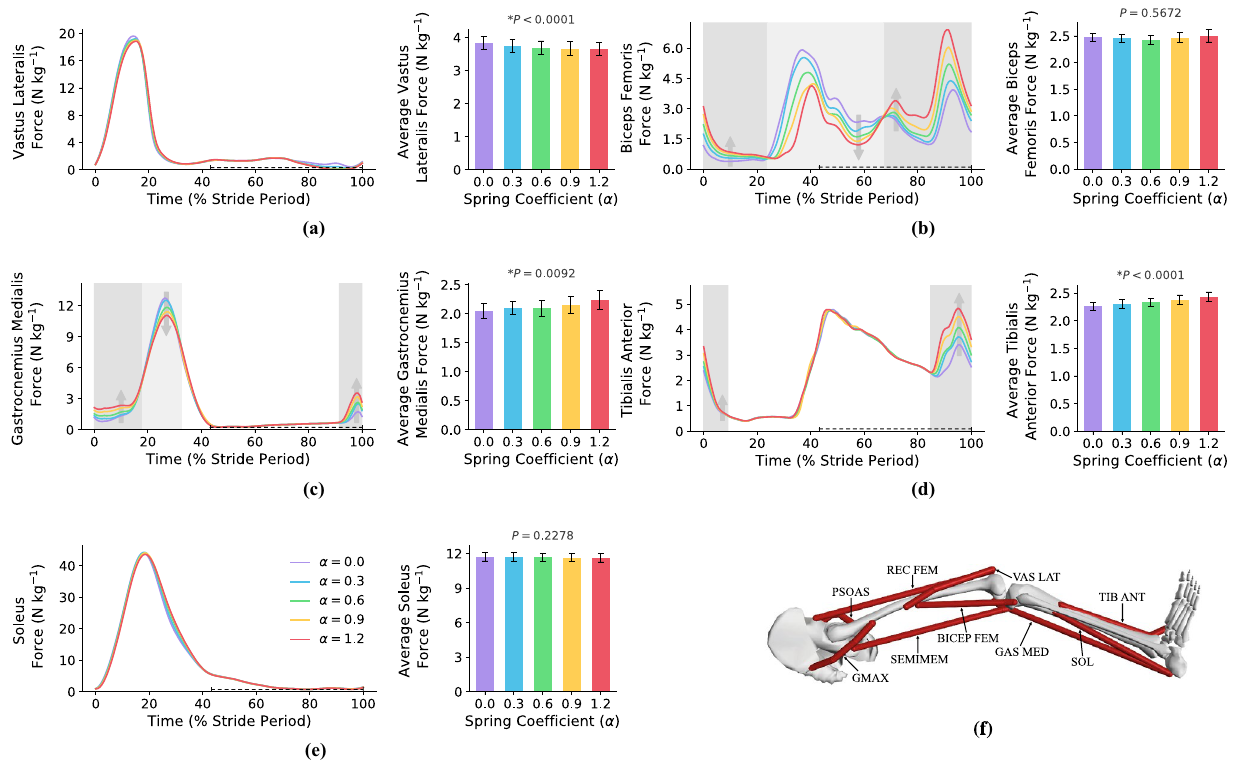
Figure 5. Other muscles’ forces . ( a – e ) Sub-figures show the effects of exoskeleton augmentation on the main muscles’ forces and their average over the whole stride except for the main hip muscles. The start of the gait cycle is at the heel-strike instant of the right leg, and all of the figures are for the right leg. The swing phase is shown with a dashed line over the horizontal axes. The background color code for all of the sub-figures is: white means no special effect, light gray means muscle force reduction, and dark gray means muscle force increment. As can be seen, the force of Soleus and Vastus Laterialis have no significant changes by exoskeleton augmentation. Besides, despite the significant changes in the Bicep Femoris force profile, the average force of this muscle shows no significant change in different spring coefficients; minimum on α = 0.6 with 2% reduction. In addition, the optimum spring coefficient for Gastrocnemius Medialis and Tibialis Anterior is on α = 0 . And, the minimum average force for Vastus Lateralis and Soleus is on α = 1.5 with 5.6% and 1.2% reductions compared to no exoskeleton case. Moreover, the average forces of these muscles have 3.8% and 0.5% reductions on α ∗ = 0.6 , respectively. N = 7 ; bars, mean; error bars, s.e.m; P values, ANOVA (random effect: participant; fixed effects: spring coefficient; significance level = 0.05 ). ( f ) shows the placement of the nine main branches of the muscles in the lower